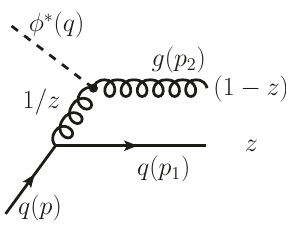
Figure 1 . Scattering of a quark o(cid:11) a virtual Higgs boson at tree